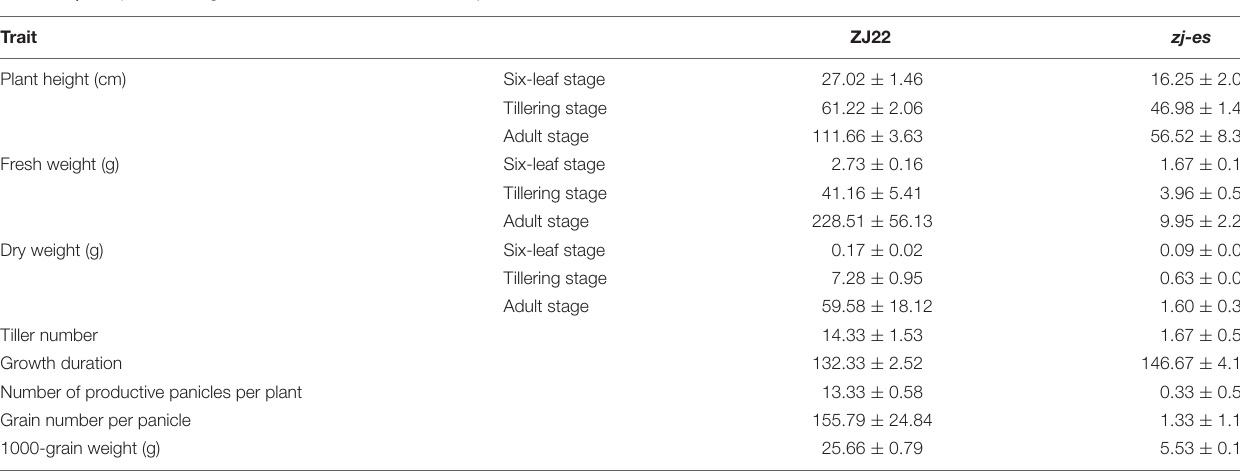
FIGURE 1 | Comparison of plant morphology between the wild type (ZJ22) and mutant ( zj-es ). The whole plant at the six-leaf stage (A) , the tillering stage (B) , and the adult stage (C) , scale bar = 5 cm; leaf genotype at the six-leaf stage (D) , the tillering stage (E) , and the adult stage (F) , the three leaves represent the flag leaf, 2nd leaf (from the top), and 3rd leaf; scale bar = 3 cm; ultrastructure of the chloroplast in the ZJ22 (G) and zj-es (H–L) at the six-leaf stage; Sg, starch grain; Og, osmiophilic granules; Ch, chloroplast; Mi, mitochondria; Thy, thylakoid, scale bar = 0.5 nm; anther of ZJ22 (M,N) and of zj-es (O,P) , red scale bar = 1 mm; pollen grains of ZJ22 (Q,R) and of zj-es (S,T) after potassium iodide staining, blue scale bar = 500 µ m. TABLE 1 | Comparison of agronomic traits between ZJ22 and zj-es